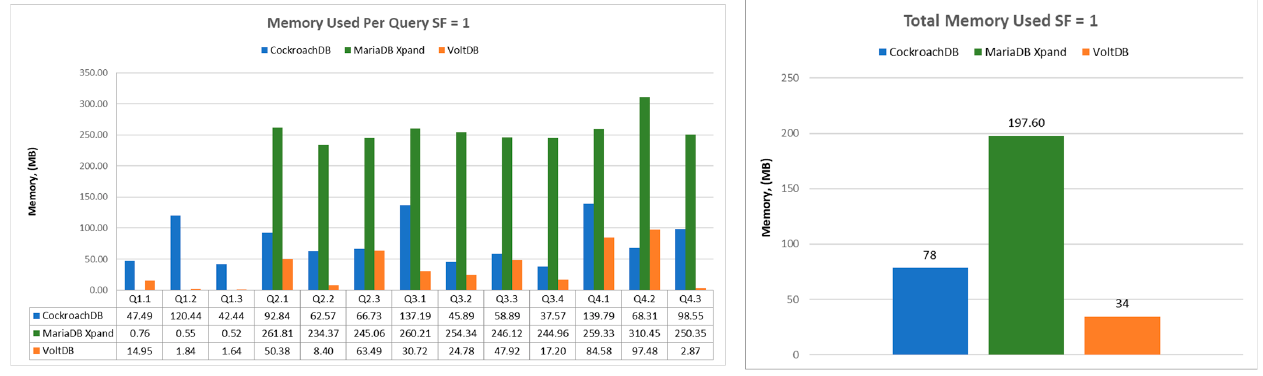
Figure 9. Results of memory used with SF = 1.